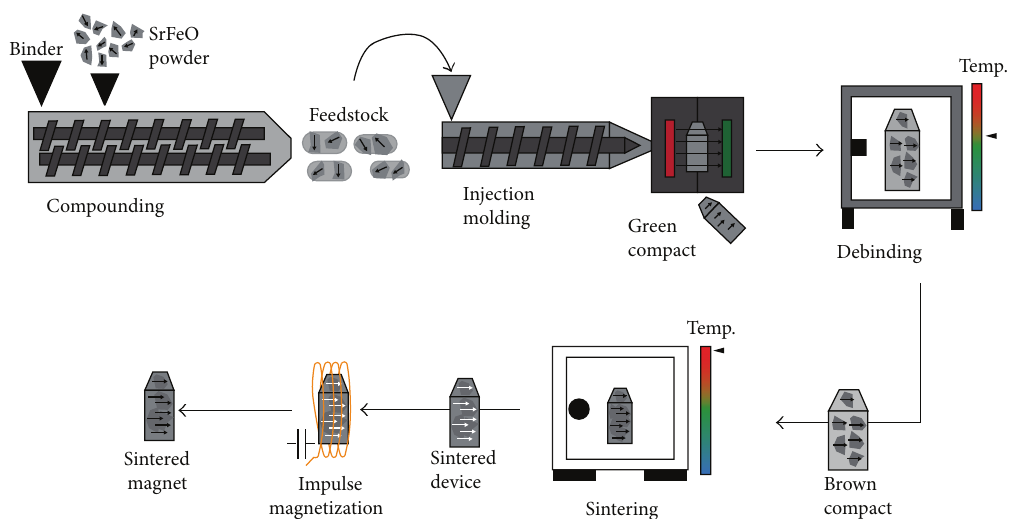
Figure 1: Process chain of ceramic injection molding to build a magnetic device (MagnetPIM).